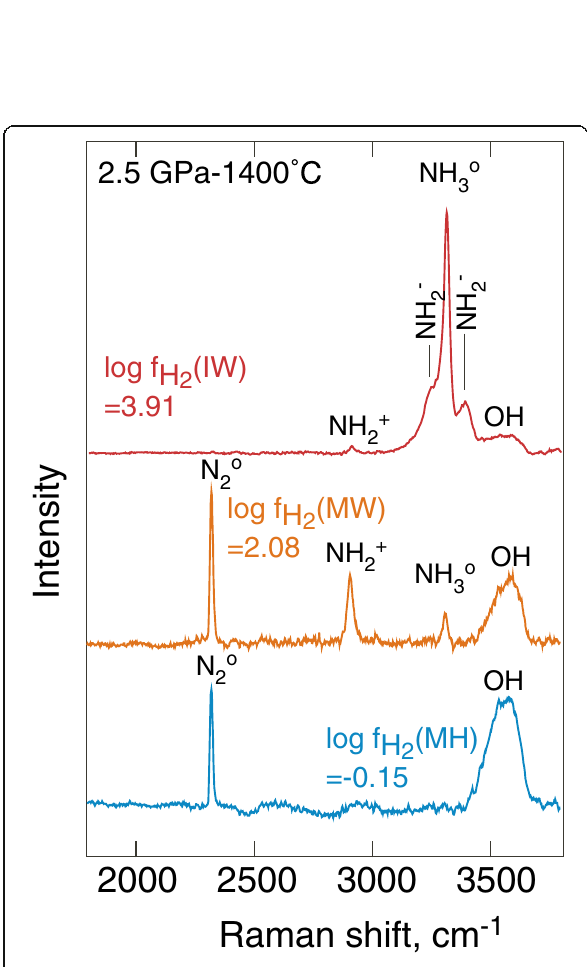
Fig. 19 Raman spectra of quenched silicate melts as a function of the hydrogen fugacity at which they equilibrated at 2.5 GP and 1400 °C (modified after Mysen and Fogel 2010)